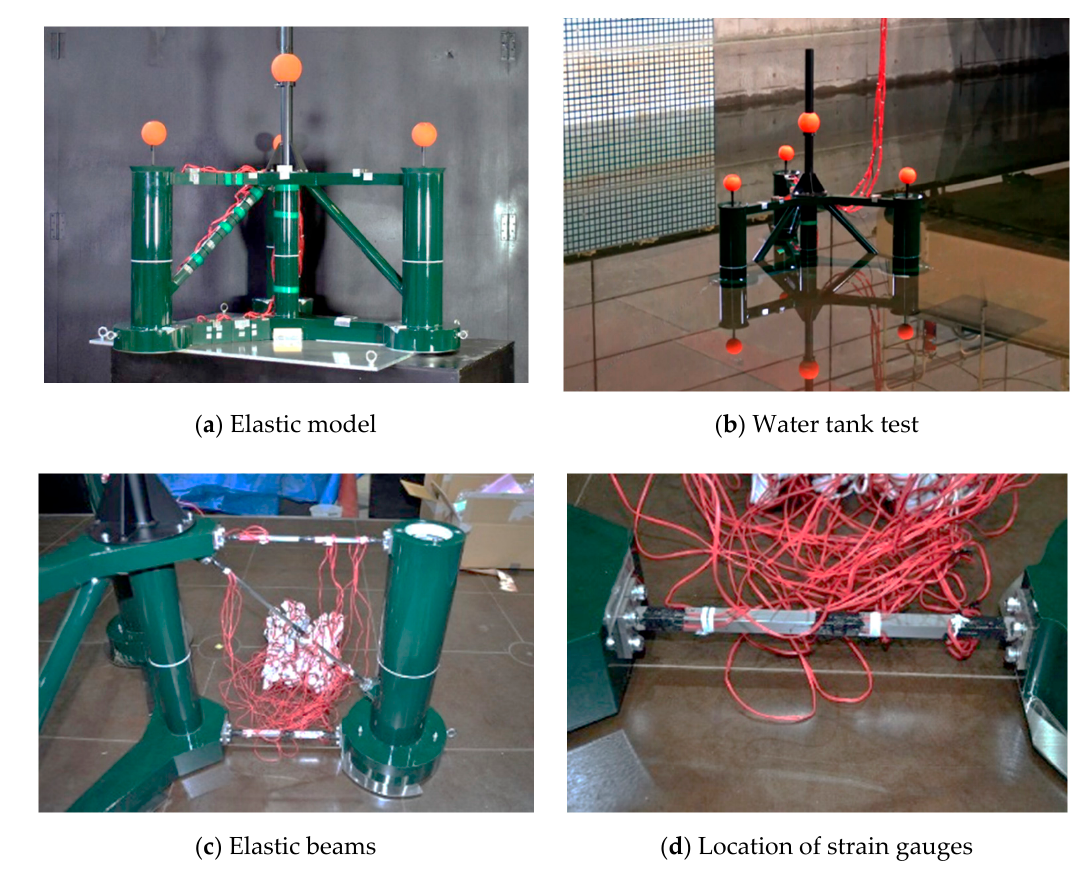
Figure 5. Overview of the elastic model and the water tank test.